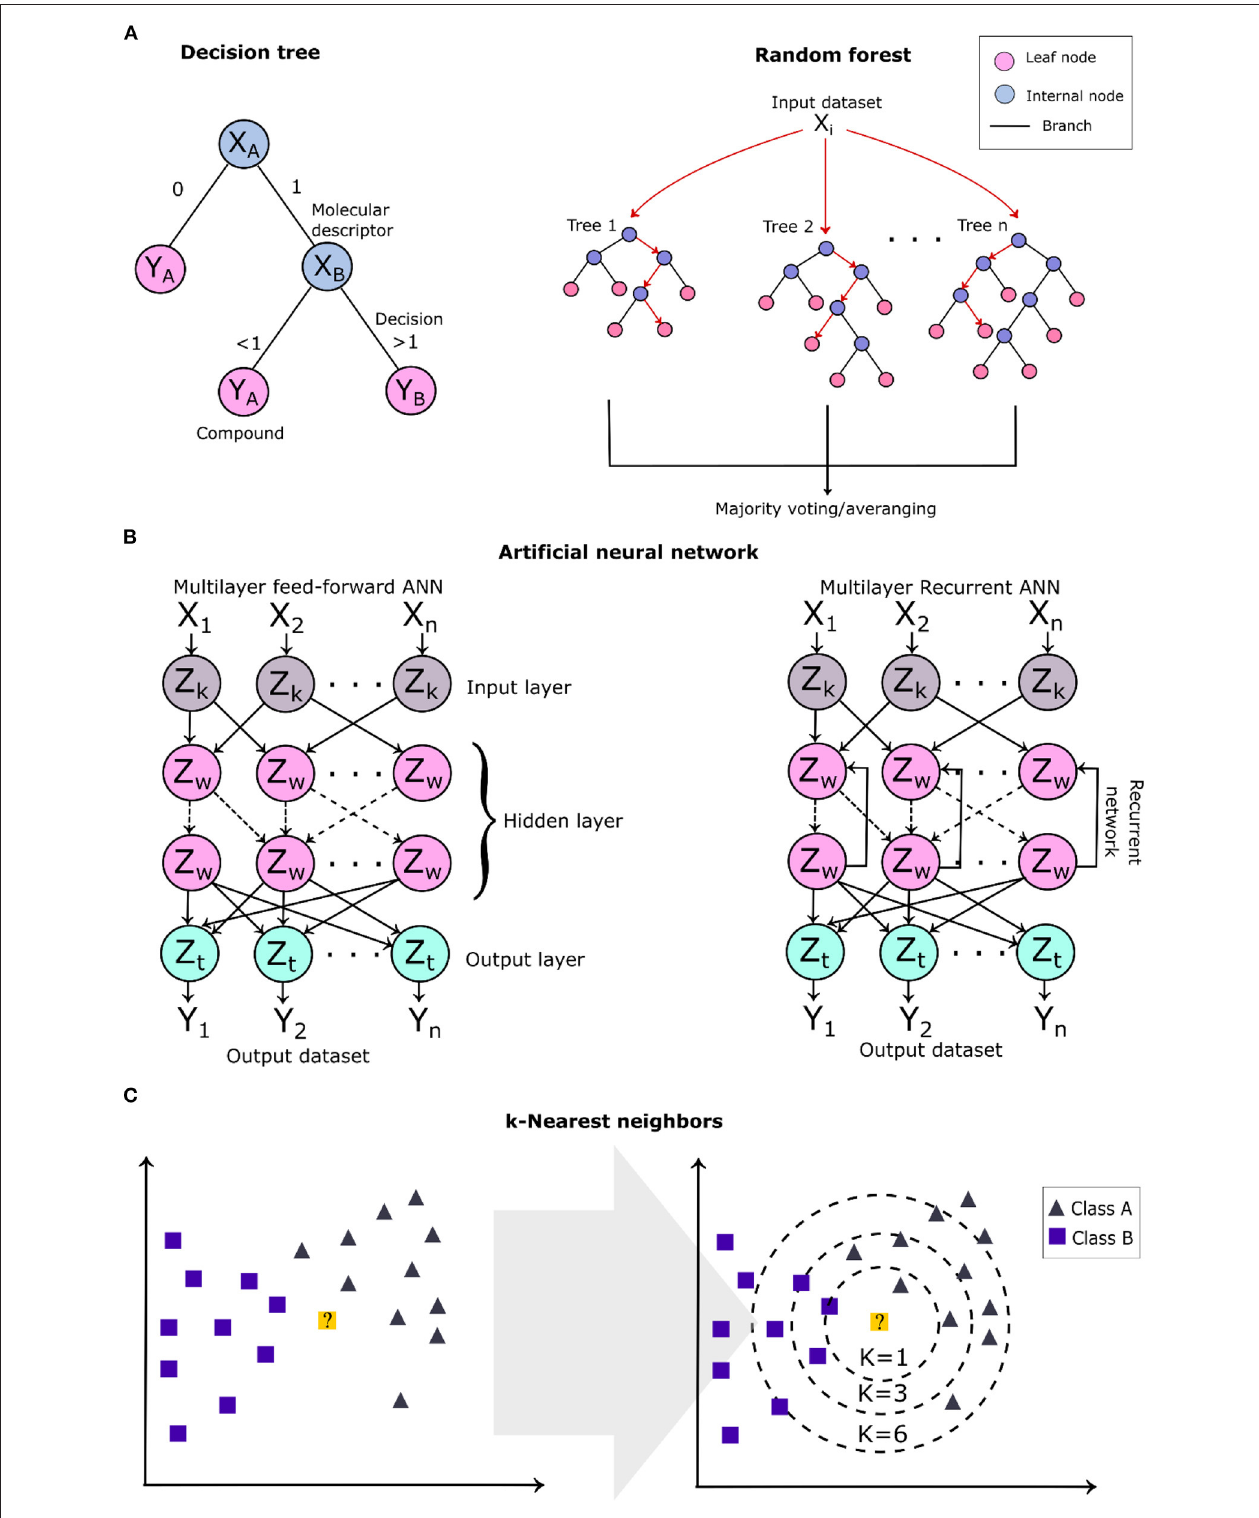
FIGURE 7 | Schematic overview of some of the machine learning algorithms applied in virtual screening. (A) Two-dimensional (2D) diagram of a single root tree of a decision tree algorithm and the general architecture of a random forest. (B) The architecture of a multilayer feed-forward and recursive artificial neural network. Z w refers to neurons of the hidden layers (internal); Z k and Z t , to the neurons of the input and output layers, respectively. (C) k -Nearest neighbor algorithm showing the learning technique to classify a new data represented by the 2D yellow point , which is classified as belonging to class A ( gray triangles ).